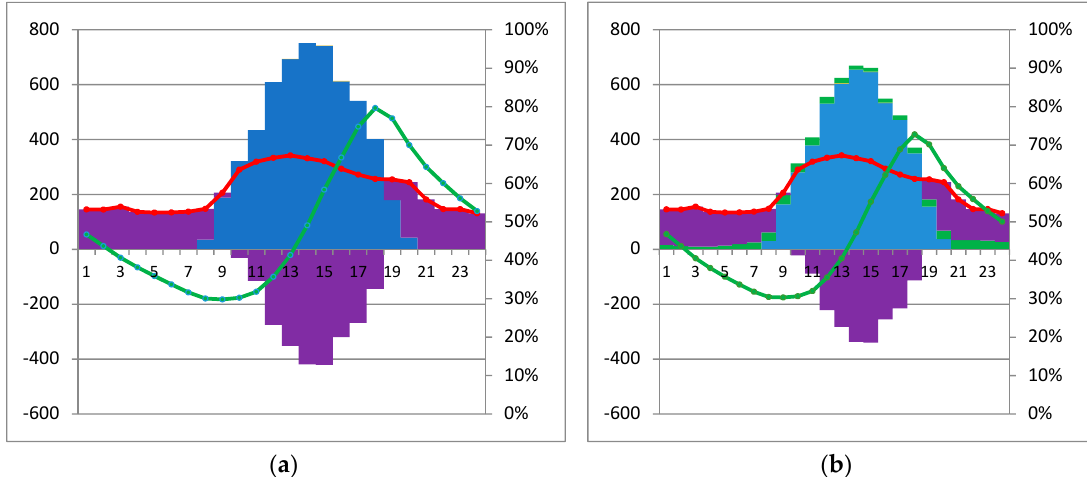
Figure 7. Day 3, 01/04/2009: Energy balance (a) without and (b) with tidal energy.